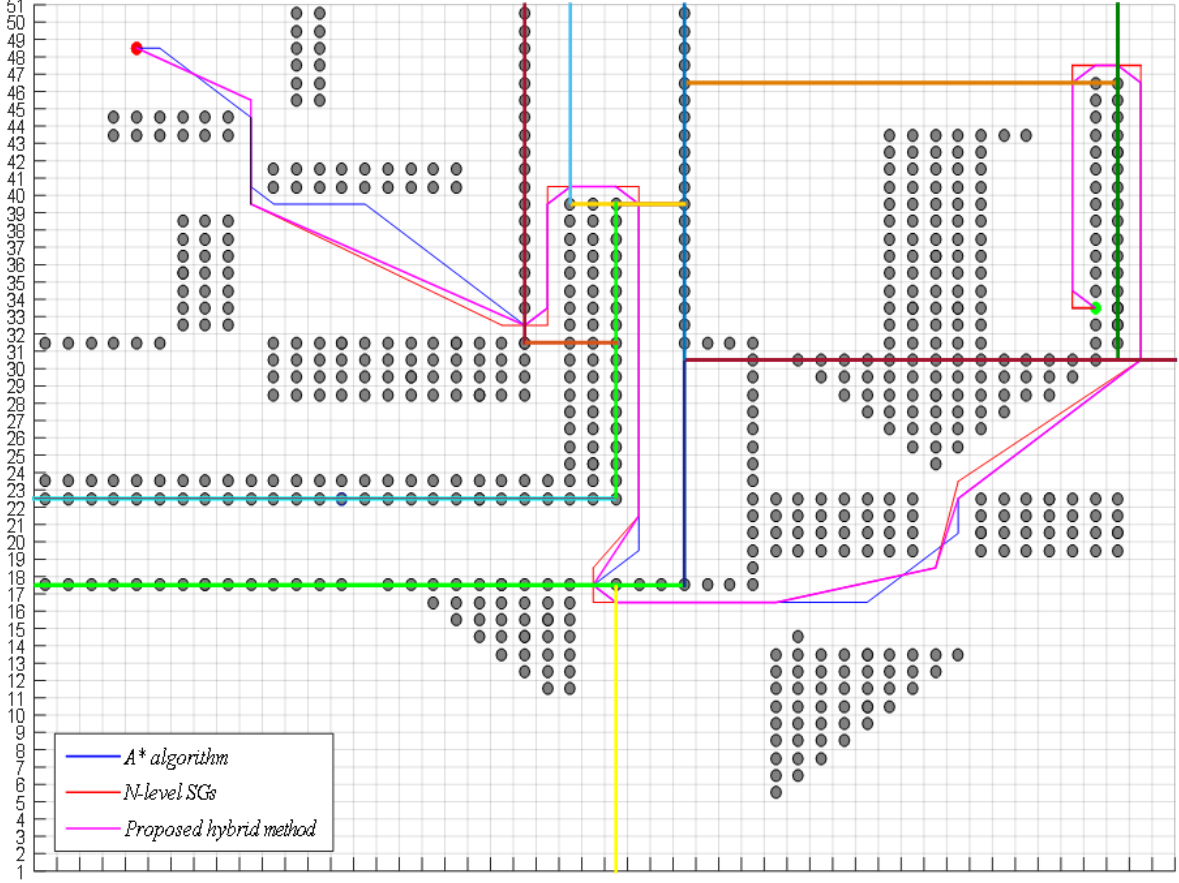
Fig. 6. Route planning for Map_3 with the different